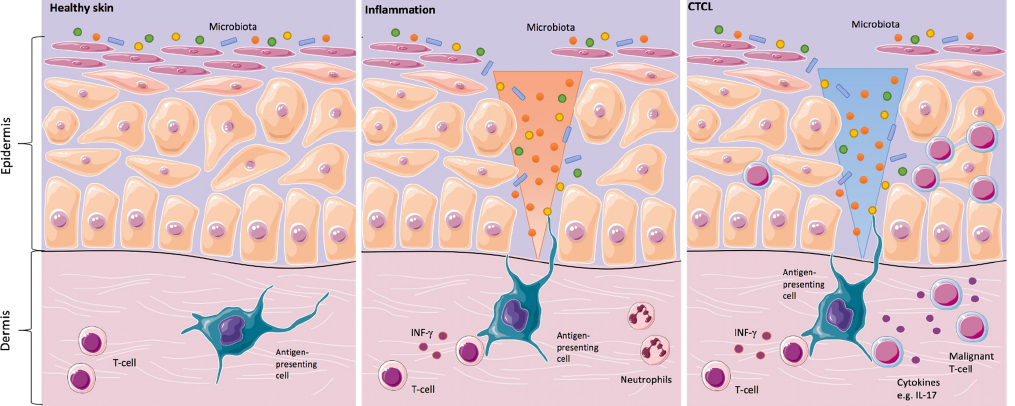
Figure 1. Skins’ interactions with microorganisms in healthy skin, inflammation, and in primary cutaneous T-cell lymphomas (CTCL). Healthy skin in homeostasis ( left image ). Classical inflamma- tory responses, as characterized by infiltrating neutrophils and monocytes, alongside interferon- γ (IFN- γ )-producing T-cells. In CTCL, a chronic antigen stimulus from interaction with microorganisms is under suspicion in the origin or/and the progression of the disease ( middle image ). For instance, Staphylococcal enterotoxin A can stimulate the activation of signal transducer and activator of tran- scription 3 (STAT3), as shown in in vitro CTCL models, resulting in an upregulation of interleukin IL-17. IL-17 might indirectly influence tumorigenesis by modulating angiogenesis and inflammation ( right image )